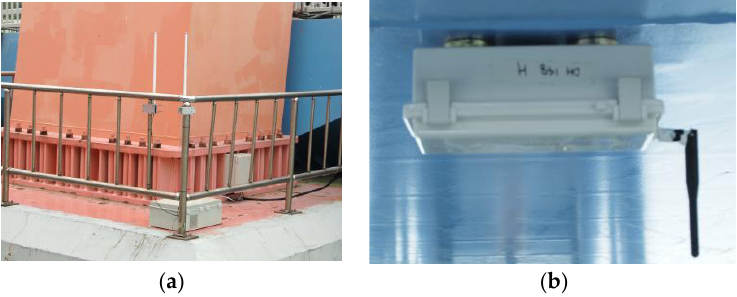
Figure 10. Illustration of the ( a ) Base station and ( b ) Wireless node.